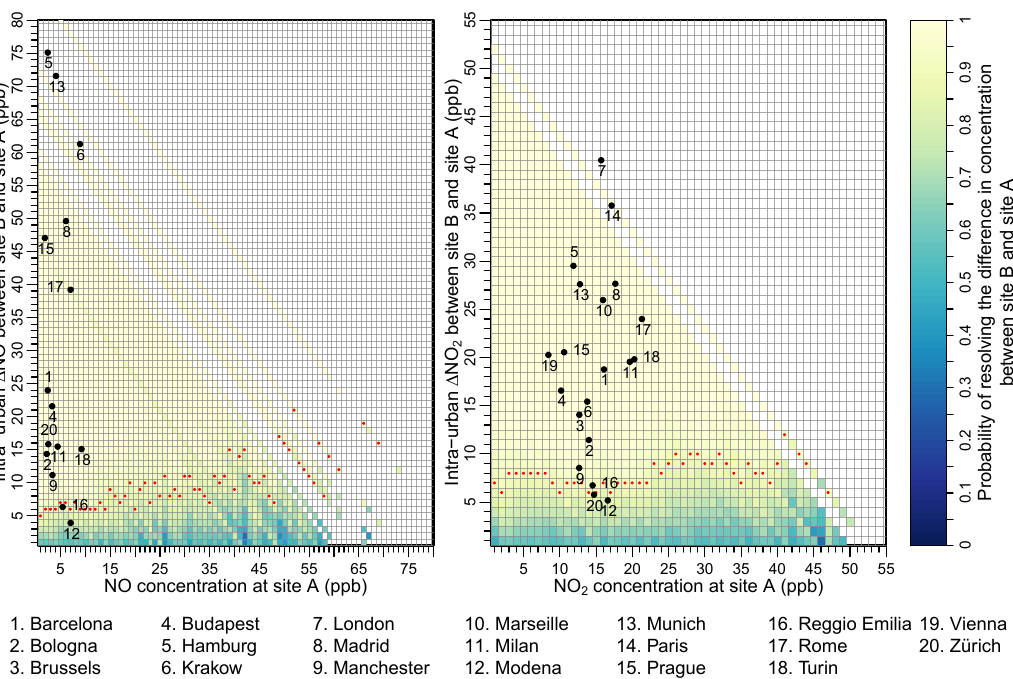
Figure 10. Probability of resolving spatial intra-urban difference in NO and NO 2 between site B and site A, with the latter exposed to lower concentrations. Red dots indicate the concentration difference between site B and A that can be detected with a probability of 90%. Numbered dot coordinates indicate pollution condition for 20 European cities: the x coordinate is the urban median concentration and the y coordinate is the median intra-urban gradient for hourly concentration data by the air quality monitoring sites within that same urban